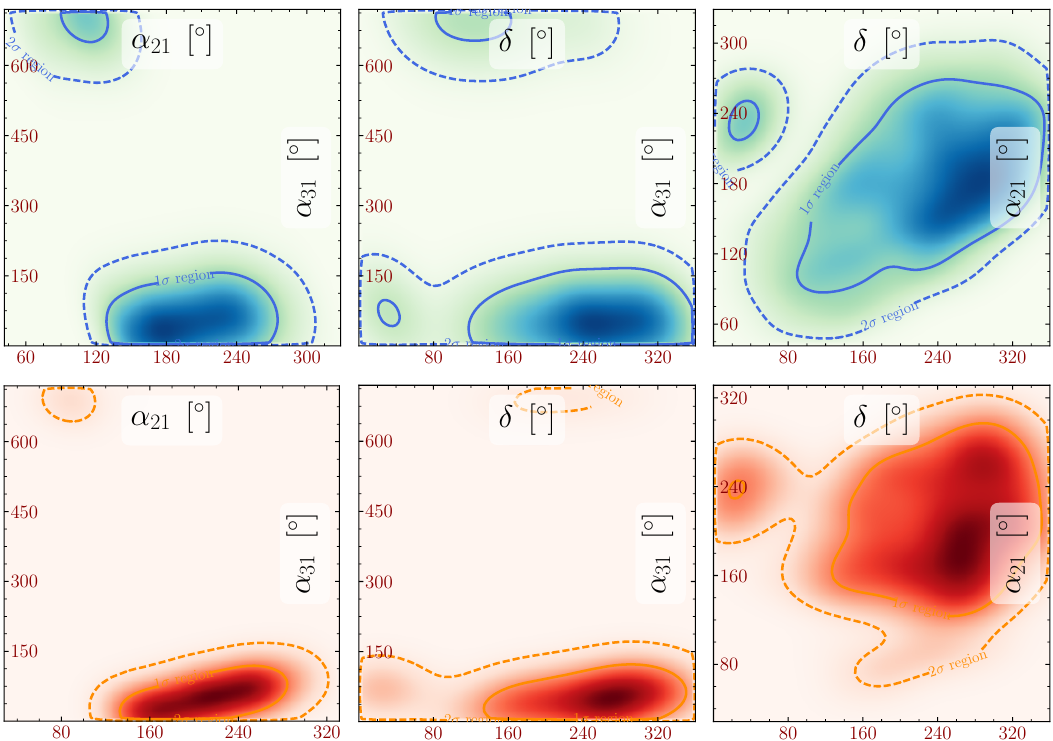
Figure 10.1: The two-dimensional projections for intermediate scale leptogenesis = 3.16 × 10 6 GeV for x = 0, y = 0, x = 180 ◦ , y = y = 180 ◦ , with CP with M 1 1 2 3 1 2 violation provided only by the phases of the PMNS matrix. The normal ordered case is colored blue / green and inverted ordering orange / red and contours correspond to = 0.21 eV, the mixing angles of the PMNS 68% and 95% confidence levels. We fix m 1 matrix and mass squared splittings of the light neutrinos are fixed at their best fit values as given by global fit data [ 250 ] . This plot was created using S UPER P LOT [ 251 ]